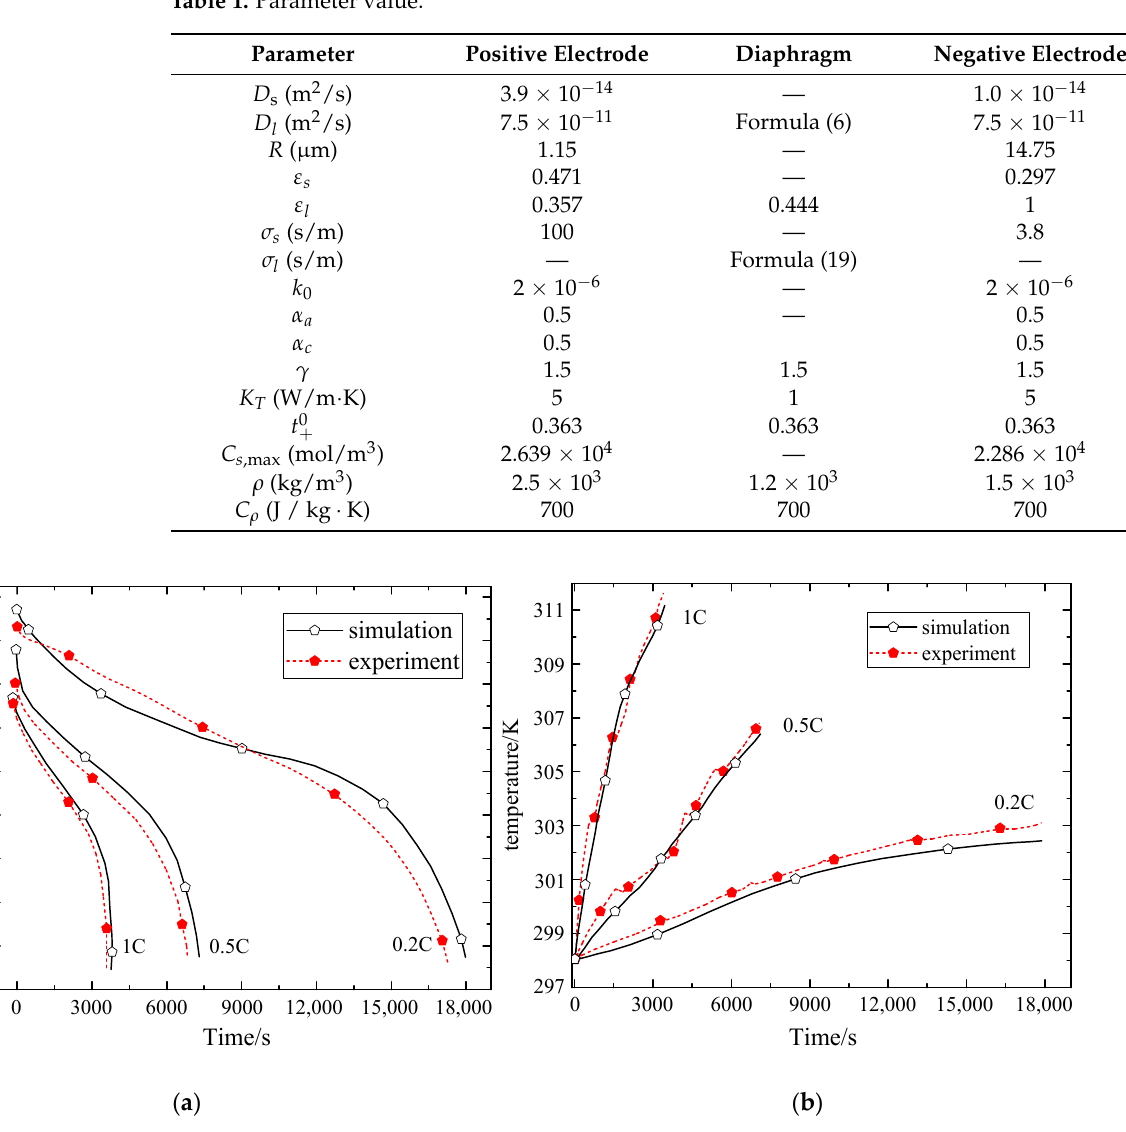
Figure 3. Comparison of experimental and simulation results; ( a ) cell voltage versus discharge time; and ( b ) temperature on battery surface versus discharge time.